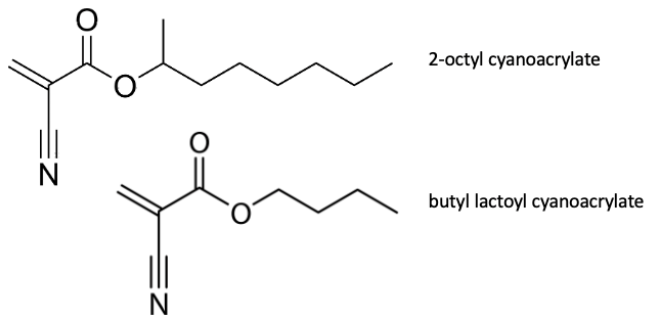
Figure 5. Chemical formulas of 2-octyl cyanoacrylate and butyl lactoyl